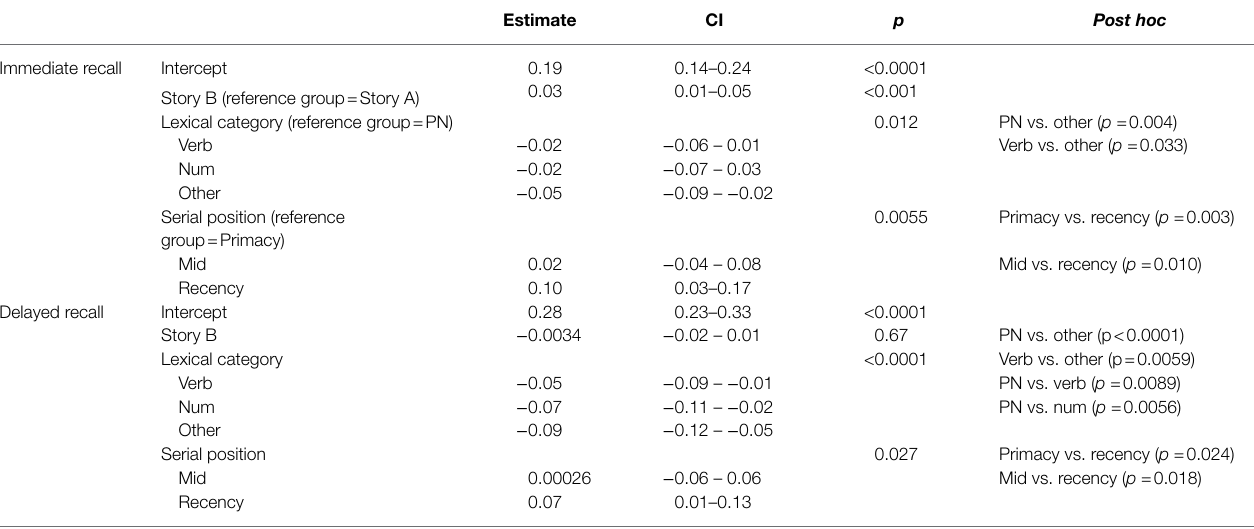
TABLE 3 | GLMM with the discrimination indices for immediate recall and delayed recall predicted by story, lexical category and serial position. Estimate CI p Post